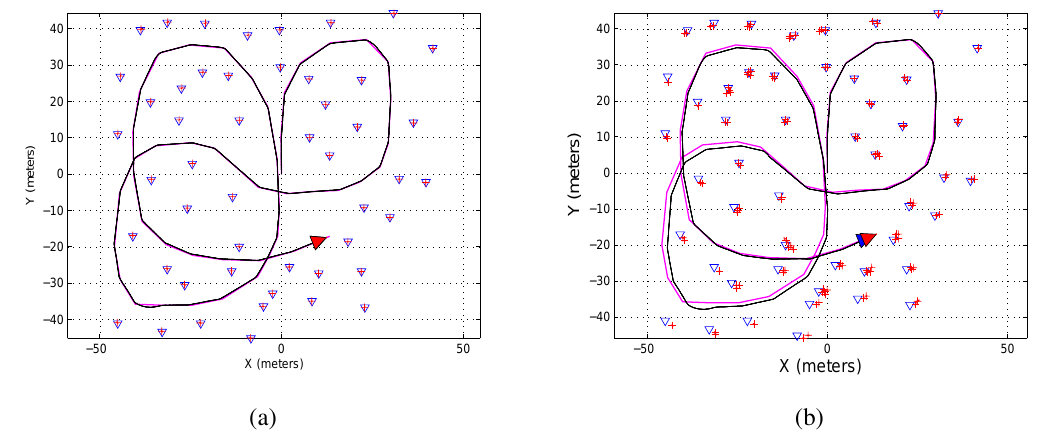
Figure 8. Map reconstruction of the environment using the maximum eigenvalue feature selection criterion on the EKF-SLAM. (a) Shows the map reconstruction when the five most significant features— LIM = 5 in Algorithm 4—were used for the correction stage of the EKF-SLAM; (b) shows the map reconstruction when LIM = 2 . The path traveled by the mobile robot is represented in a solid black line and the path estimated by the SLAM in solid magenta; the features are represented by blue triangles and the ellipses of uncertainty associated with each feature are in solid red.